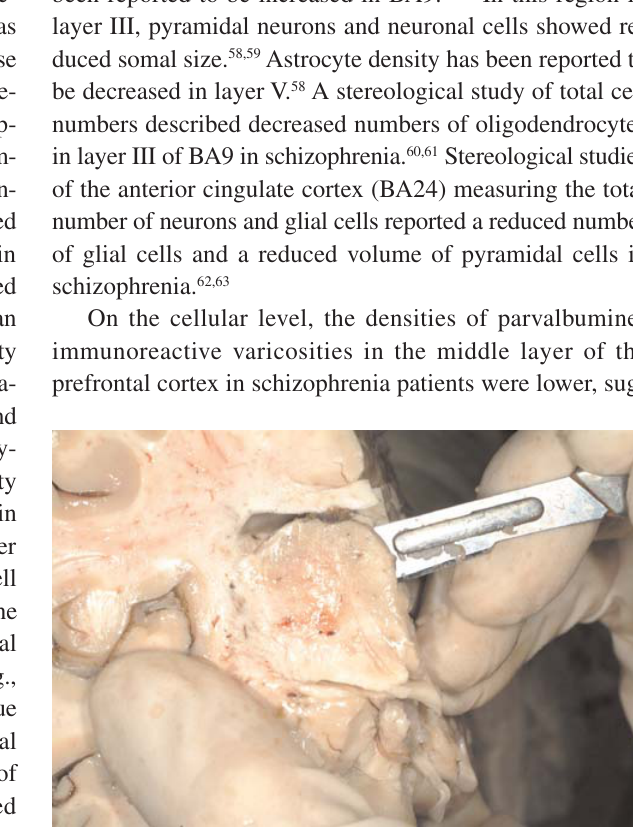
Figure 2 - Dissection of the thalamus (mediodorsal